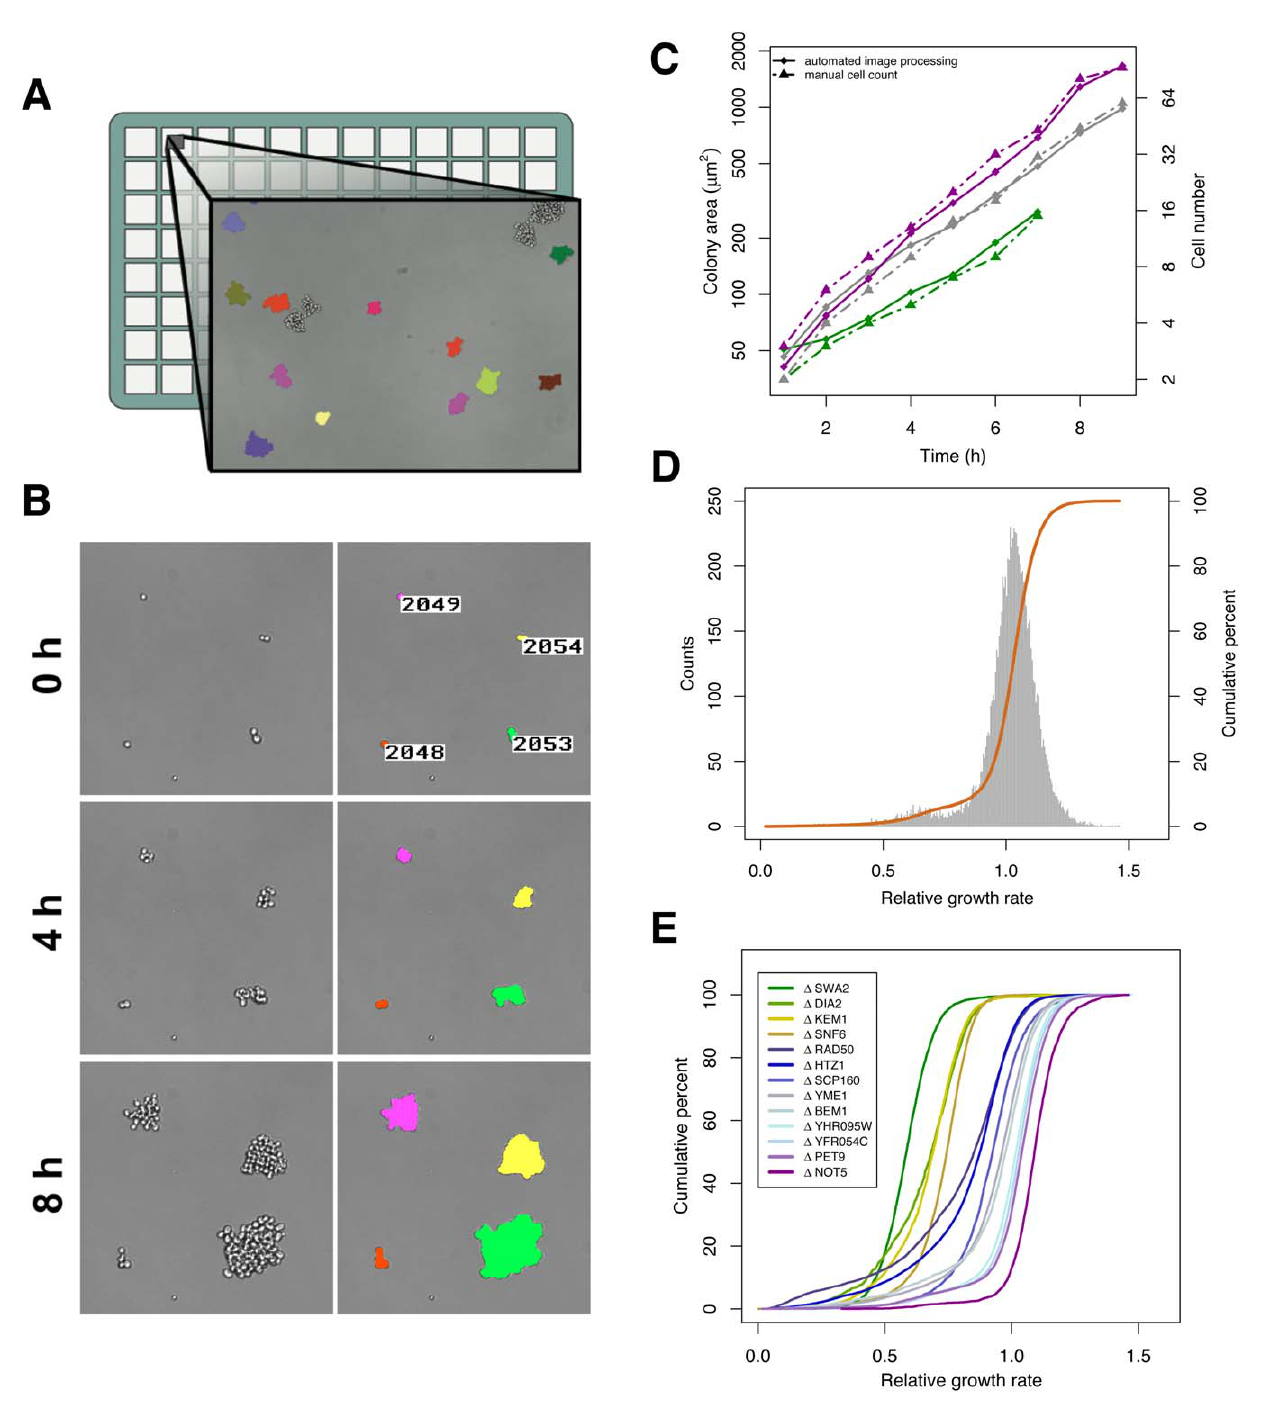
Figure 1. A new high-throughput assay to measure growth rate variance in yeast. (A) A schematic of the assay. Cells in logarithmic growth are plated ata low densityon a glass-bottomed multi-well plate. Low-magnificationtime-lapsebright-field images are captured in a highly parallelized manner. Custom-written software tracks colony area over time. (B) Isogenic cells grow at different rates. Time-lapse images of a portion of one field (left) and the output of image analysis software (right). (C) Microcolonyarea correlates withcell number. Representative traces of fast-(purple),medium- (grey),and slow- (green) growing microcolonies from a strain of the yeast deletion collection containing the knockout of YFR054C , an open reading frame with dubious function. Colony area as determined by automated image processing (solid lines, diamonds) and cell number as determined by a manual count (dashed lines, triangles) are plotted over time. Colonies generally display log-linear growth over the duration of the experiment. (D) Isogenic cells display a wide distribution of growth rates. A histogram of growth rates (grey) and a cumulative growth rate distribution (orange) of a population of , 17,000 isogenic microcolonies of the YFR054C knockout. (E) Gene deletions alter both growth rate mean and variance. Cumulative growth rate distributions of strains from the yeastdeletioncollection:twoknockoutsof openreading frames withdubious function( YFR054C and YHR095W ), twoknockoutsthatare unabletogrow without mitochondrial function (petite-negatives PET9 and YME1 ), and nine knockouts with diverse functions that have been shown to result in cell-to-cell heterogeneity in protein expression or morphology ( SWA2 , DIA2 , KEM1 , SNF6 , RAD50 , HTZ1 , SCP160 , BEM1 , and NOT5 ). Note that a steep slope for the cumulative growth rate distribution indicates a low variance in growth rate.